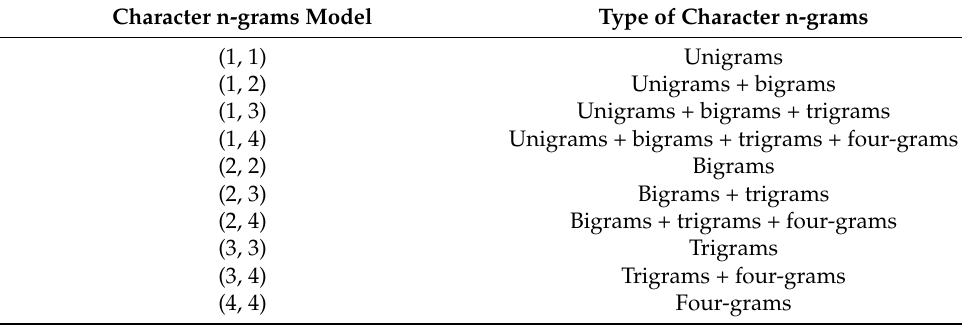
Table 2. The different n-gram combinations that were tested in our experiments.